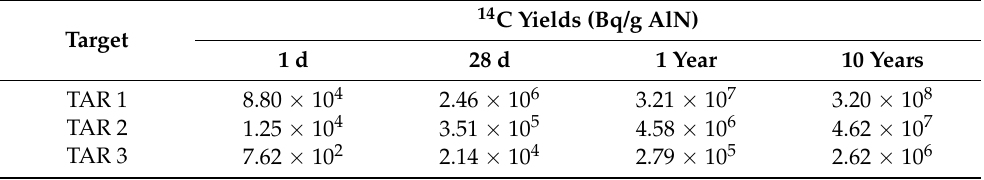
Table 2. 14 C yields of AlN at various irradiation times.